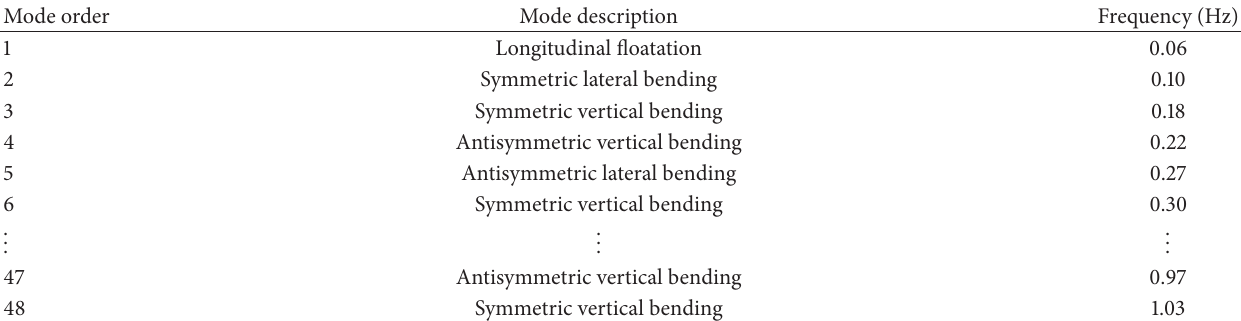
Figure 1: Layout of the Sutong Yangtze Bridge: (a) longitudinal layout (unit: m); (b) cross-section (unit: mm). Table 1: Frequencies and modes of the Sutong Yangtze